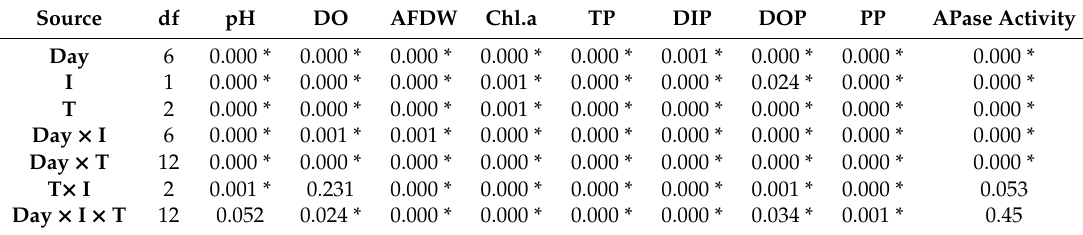
Table 1. Results ( p values) of repeated measurement ANOVA. Illumination (I), time (day), and temperature